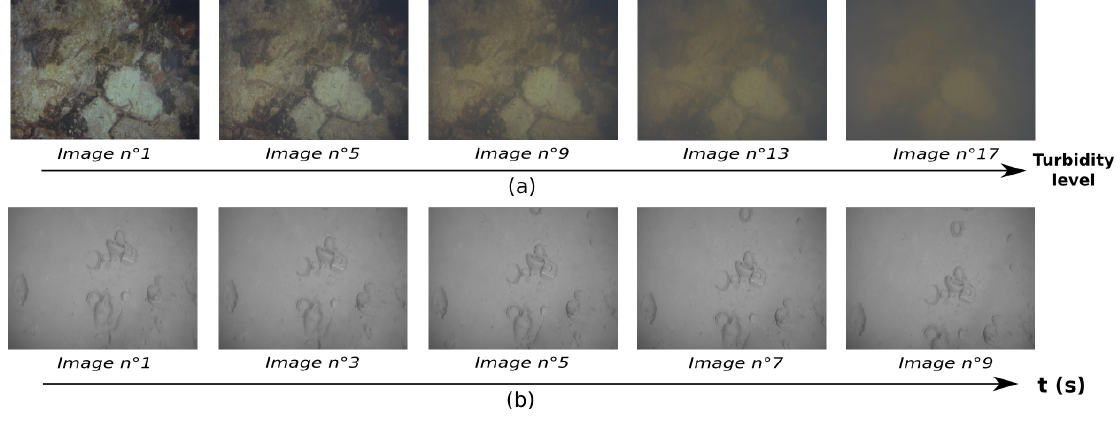
Figure 2. Images used to evaluate the tracking of features. ( a ) Images from the TURBID dataset [24]. ( b ) Images acquired on a deep antic shipwreck (depth: 500 m, Corsica, France)—Credit: DRASSM (French Department of Underwater Archaeological